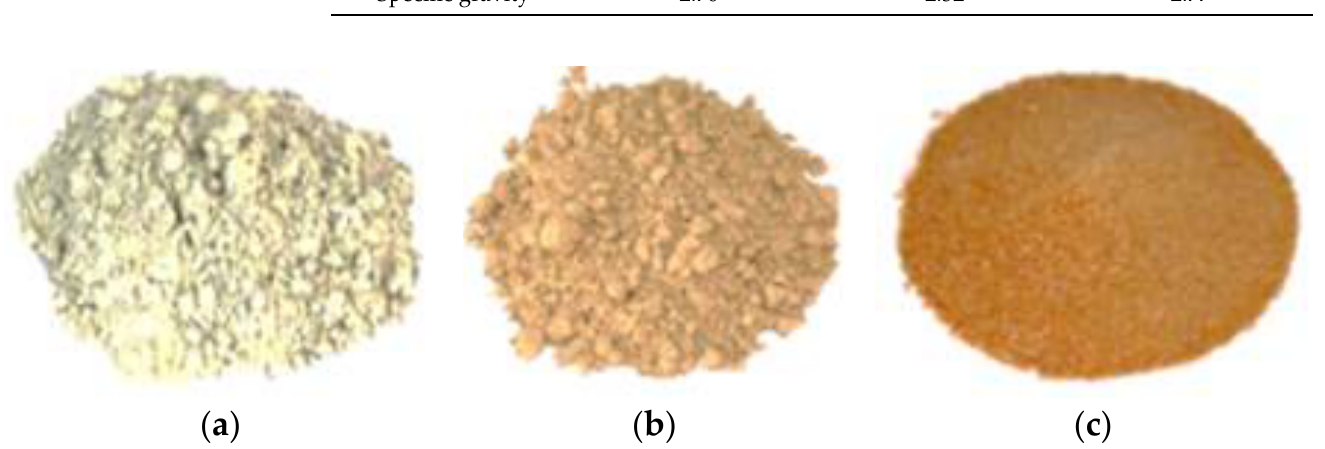
Figure 1. Physical appearance of ( a ) slag, ( b ) fly ash, and ( c ) dune sand.